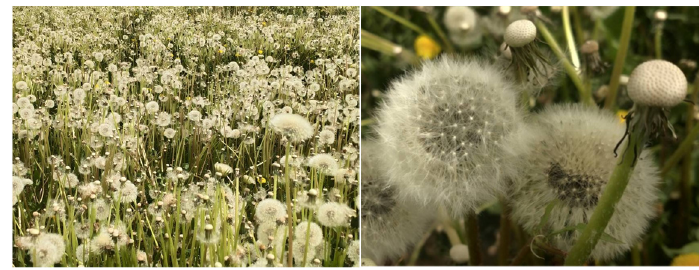
Figure 18. Photos of dandelion plants and dandelion seed crown balls.